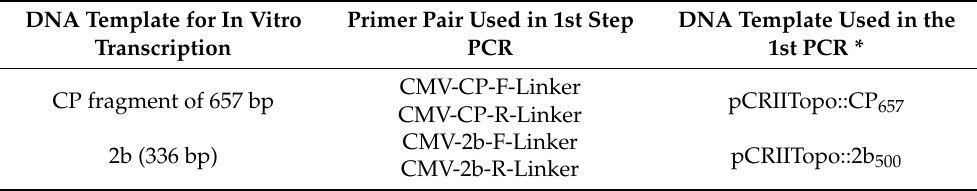
Table 2. Primer pairs and PCR conditions used to generate DNA templates for in vitro transcription. DNA Template for In Vitro Primer Pair Used in 1st Step DNA Template Used in the Transcription PCR 1st PCR * CP fragment of 657